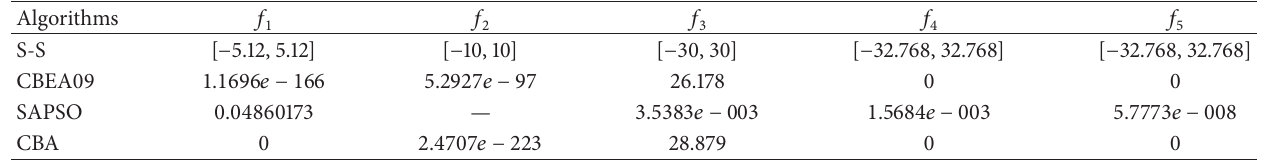
Table 4: Experimental results comparison between CBEA09, CBA, and